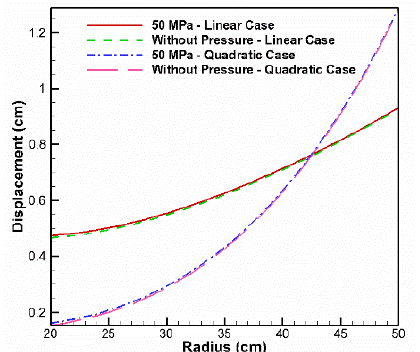
Figure 9. Tangential stress: q T = 0 o C , T ref